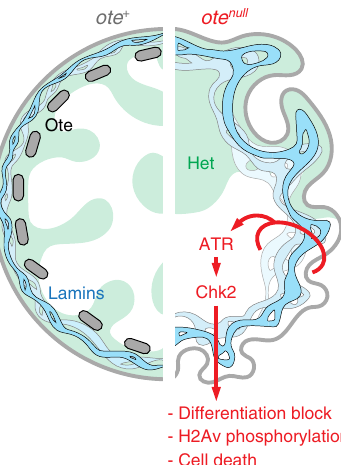
Fig. 8 Loss of Ote fi n activates a NL checkpoint in GSCs. In ote + / + GSCs (left side), Ote (gray bars) resides within the NL, stabilizing NL structure (blue ribbon) and heterochromatin (green shading) contacts. In ote − / − GSCs (right side), the NL becomes thick and deformed, causing NL dysfunction that activates a checkpoint pathway. This pathway uses the ATR and Chk2 kinases, leading to blocked differentiation, H2Av phosphorylation, and, ultimately, death of GSCs. As loss of ATR/Chk2 in ote mutants rescues oogenesis, but not embryogenesis, we suggest this NL checkpoint pathway functions to ensure that healthy gametes are passed on to the next